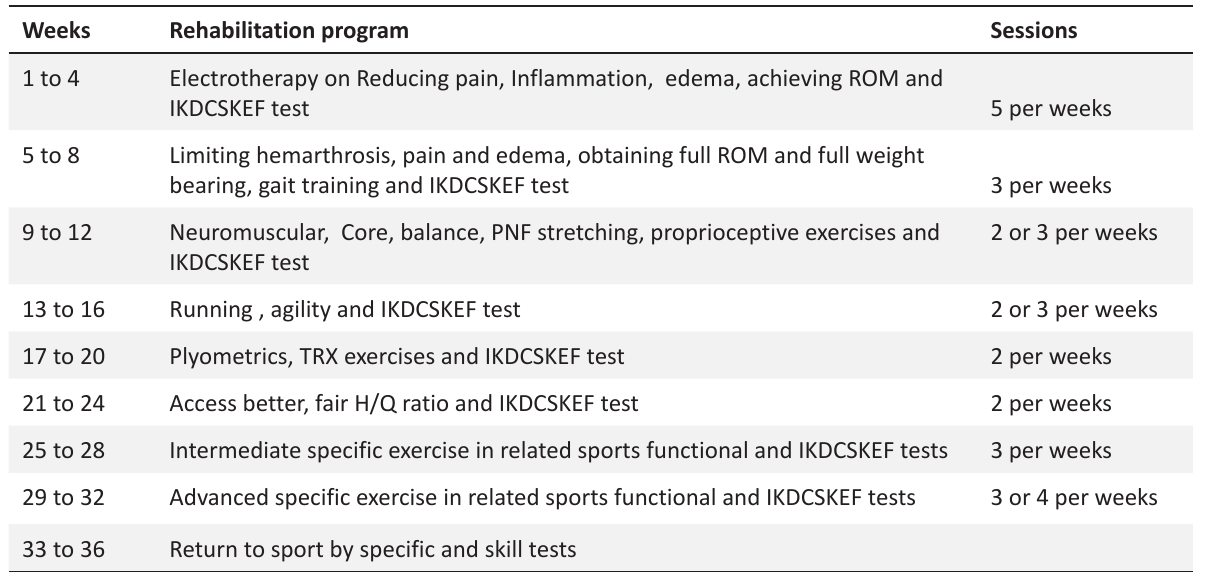
Table 1. ACL reconstruction rehabilitation